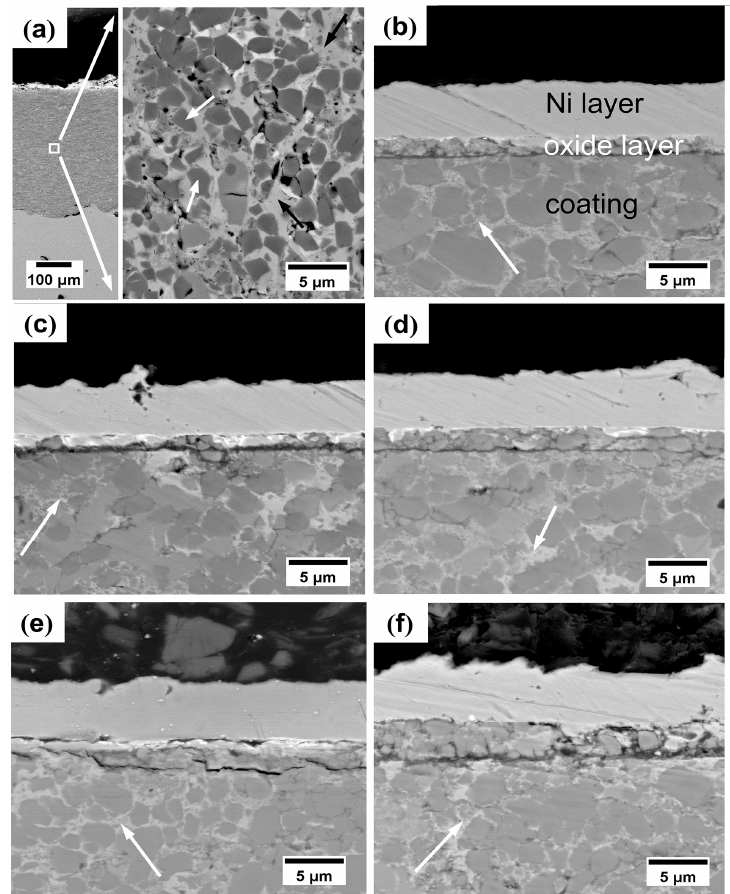
Figure 3. ( a ) Cross-sectional microstructure of the as-sprayed coating; ( b – f ) cross-sectional SEM images of the coatings after annealing at 600 °C for 24, 48, 96, 192 and 384 h, respectively. The white arrows in ( b – f ) indicate the precipitation of secondary carbide particles. ( b – f ) indicate the precipitation of secondary carbide